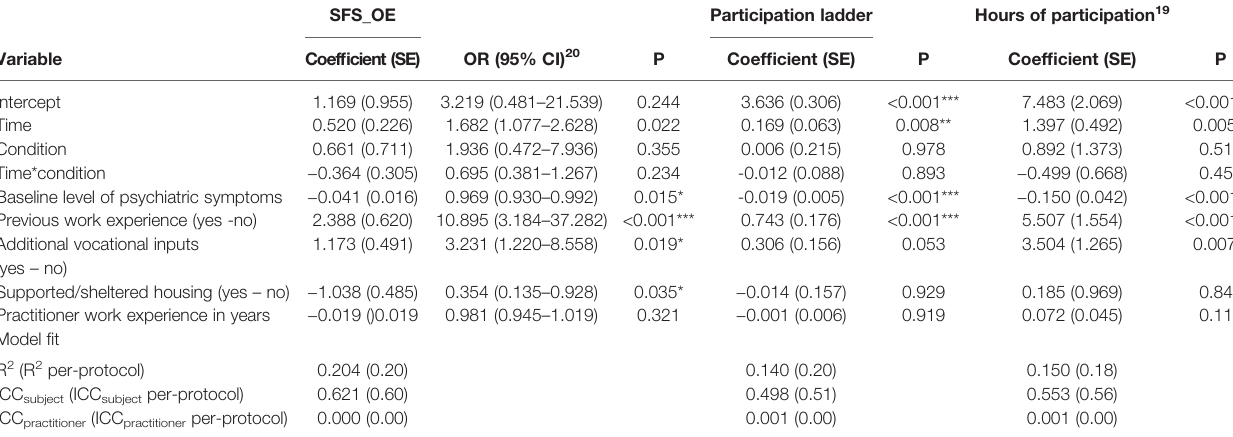
TABLE 3 | Multilevel model including possible confounders for the primary outcome